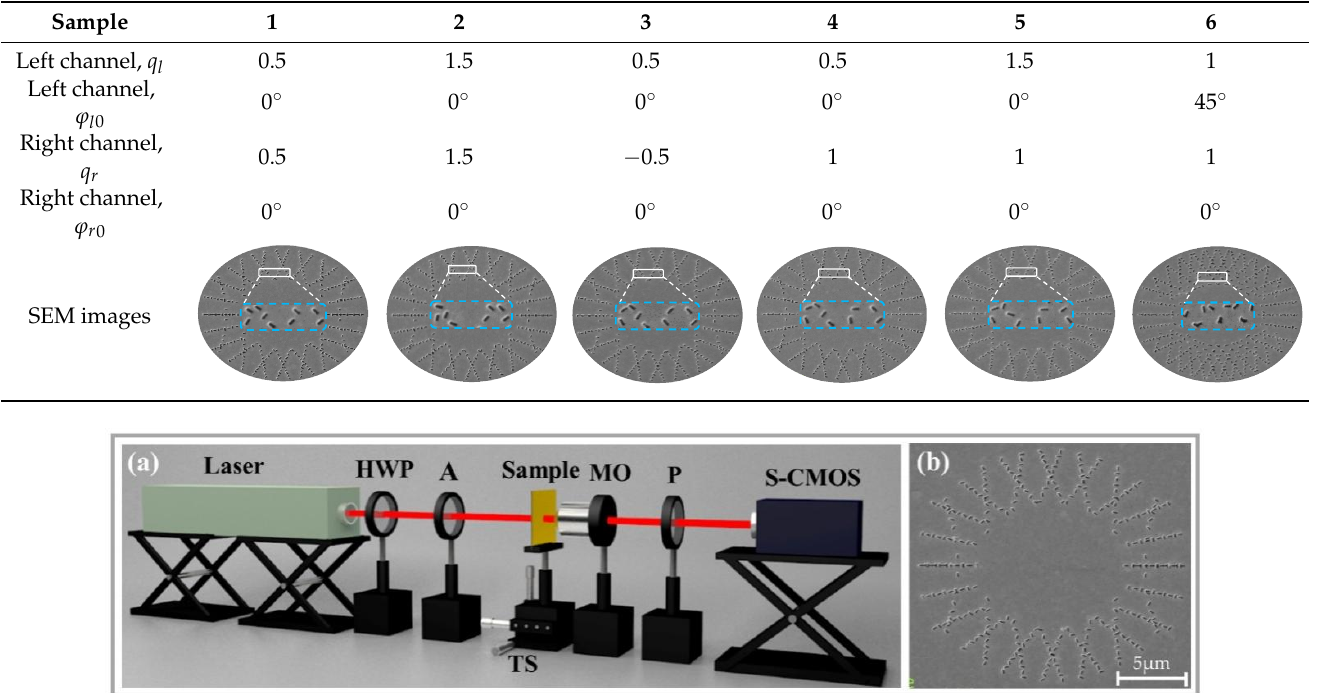
Table 1. Parameters of Designed Samples and SEM images.